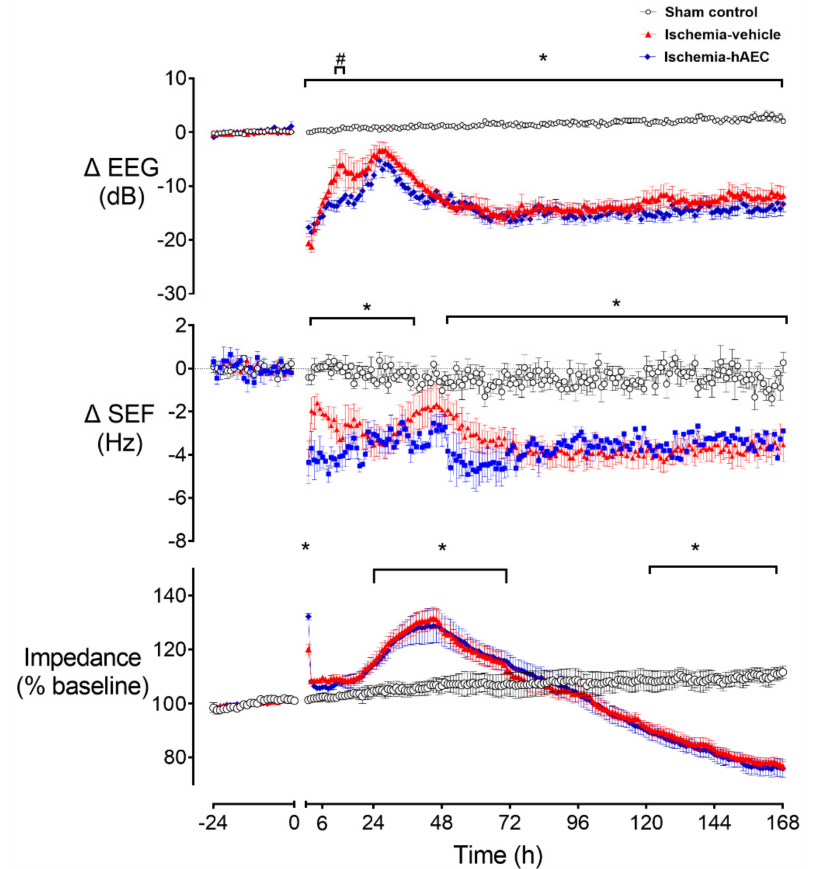
Figure 1. Changes in electroencephalogram (EEG) power, spectral edge frequency (SEF) and impedance before and after 30 min of global cerebral ischemia in near-term fetal sheep in the sham control (n = 8), ischemia-vehicle (n = 7) and ischemia-hAEC groups (n = 6). Data are 1 h averaged mean ± SEM * p < 0.05 vs. sham control, # p < 0.05 vs. ischemia-vehicle